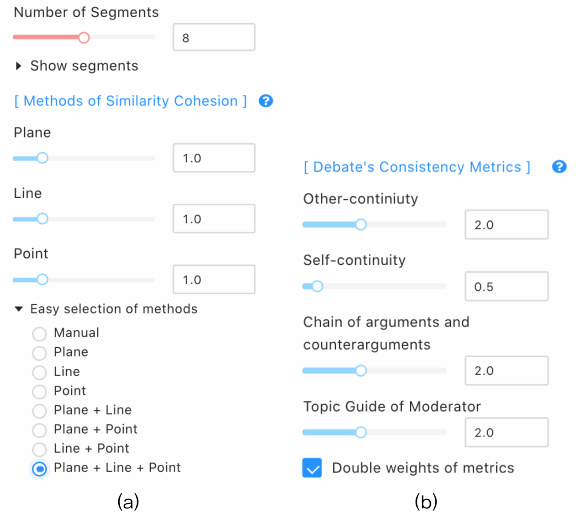
Figure 29. A controller with all debate consistency metrics applied. ( a ) Control variables are shown. The number of topic segments was controlled to 8. Similarity cohesion calculation methods were controlled with the weights for Plane, Line, and Point in a 1:1:1 ratio. ( b ) Weights of all debate consistency metrics were doubled in the direction of improving internal